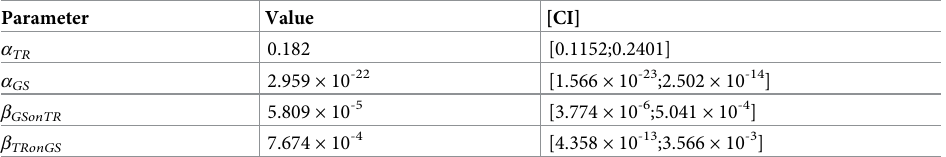
Table 8. Dual infection: Estimated values and 90% confidence intervals (CI) of the selected model (M3) parame- ters. The 90% CIs are estimated via bootstrap.